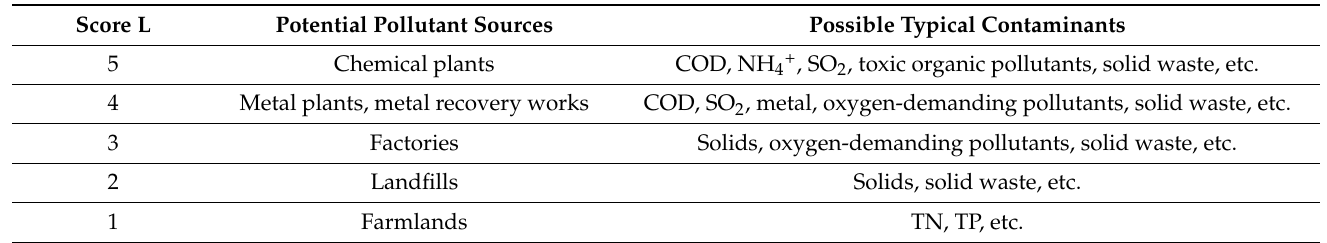
Table 1. Scores of potential pollutant sources with typical pollutants at different hazard